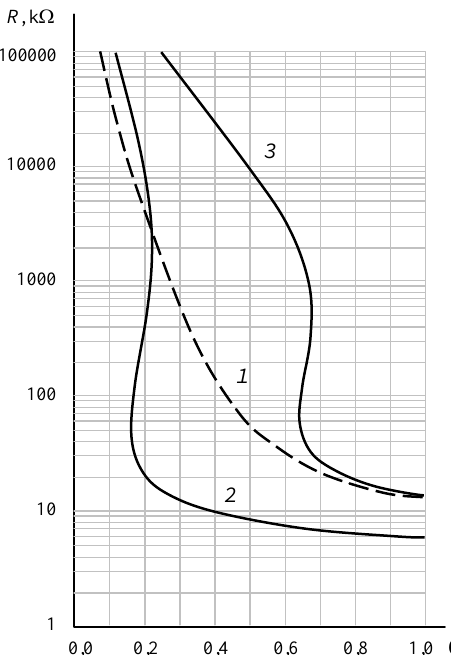
Fig. 2. The R ( θ ) dependences at β 0 = 2, C = 5,87 ( 1 ); β 0 = 1, C = 5,87 ( 2 ); and